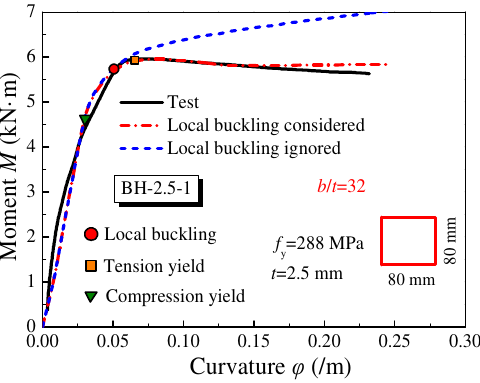
Figure 10. The comparisons of predicted M-φ curves with test results (Guler et al. [37]). For specimen PB-100 in Figure 9, the tension yield occurred first. Because of the small value of b / t (24), the local buckling occurred at high curvatures, and the local buckling